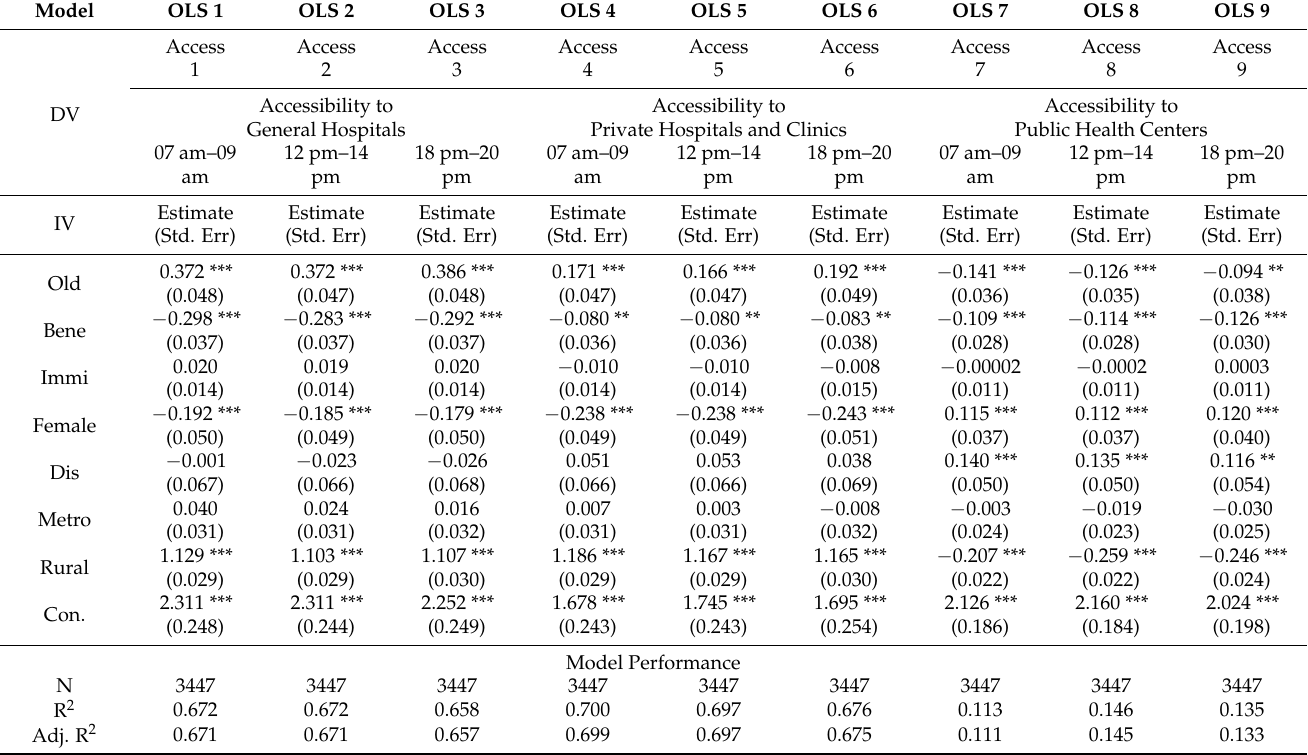
Table 6. Socioeconomic Inequality in Accessibility to Healthcare Services by